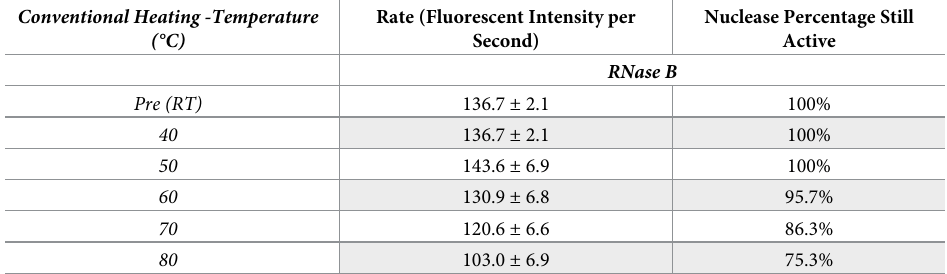
Table 1. RNase B rates and percentage still active post conventional heating for 1 minute between 40˚C and